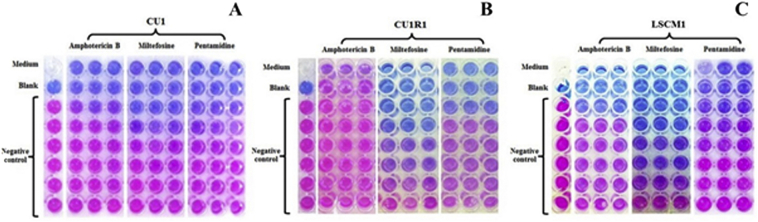
Colorimetric assay using the PrestoBlue reagent; amphotericin B, miltefosine and pentamidine were test against three L. martiniquensis promastigote strains CU1, CU1R1 and LSCM1 as shown in panels A, B and C, respectively.